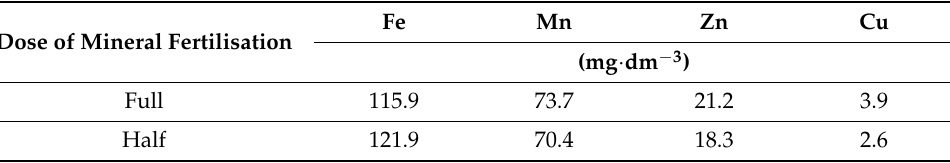
Table 3. The contents of soluble forms of Fe, Mn, Zn, and Cu in nursery soil (mean values for